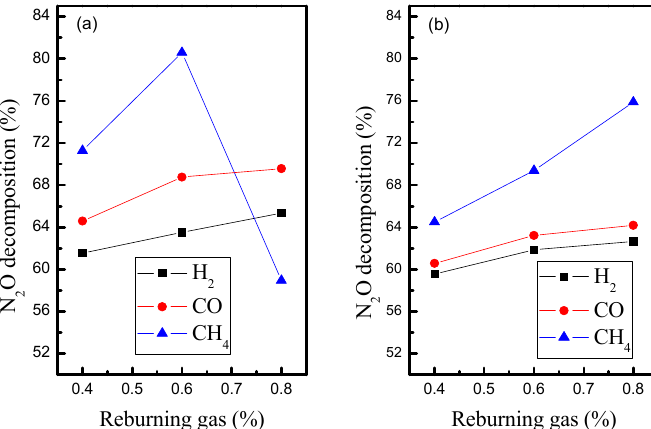
Figure 5. Relationship of heterogenous N oxygen content in flue gas: ( a ) O 900 °C).